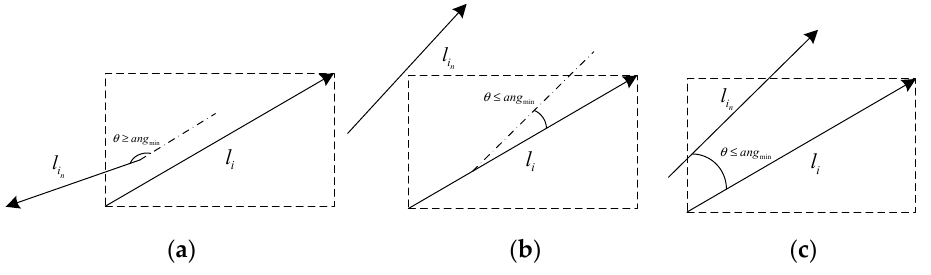
Figure 4. Various line segments: ( a ) the main directions of adjacent line segments are inconsistent; ( b ) adjacent line segments are not in the peripheral matrix of the main line segment; ( c ) set of line segments that meet the conditions for merging.